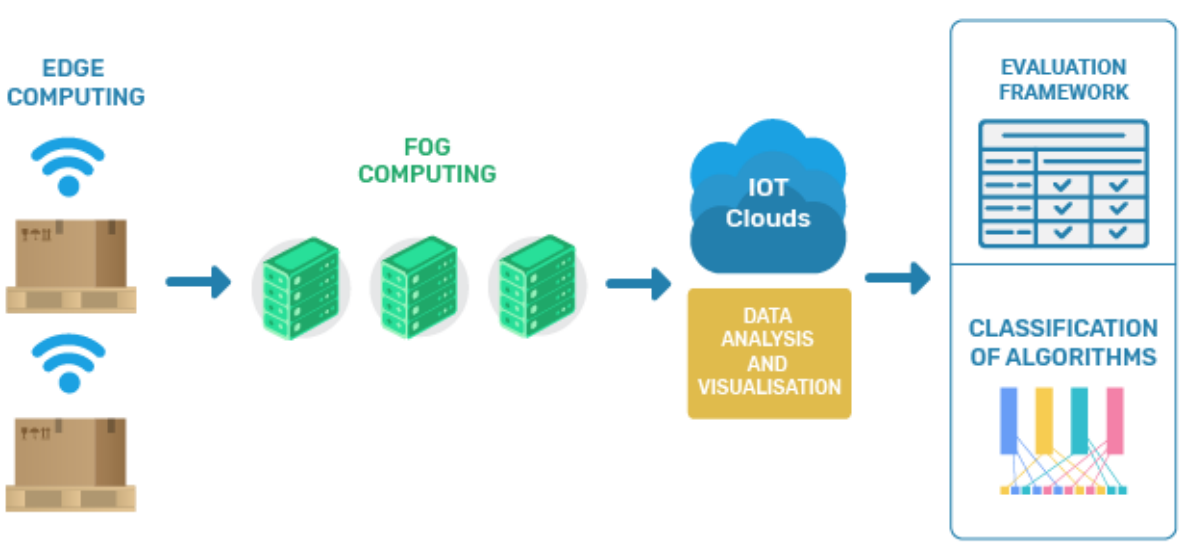
Figure 2. An example of cloud/fog/edge architecture for a smart pallet case